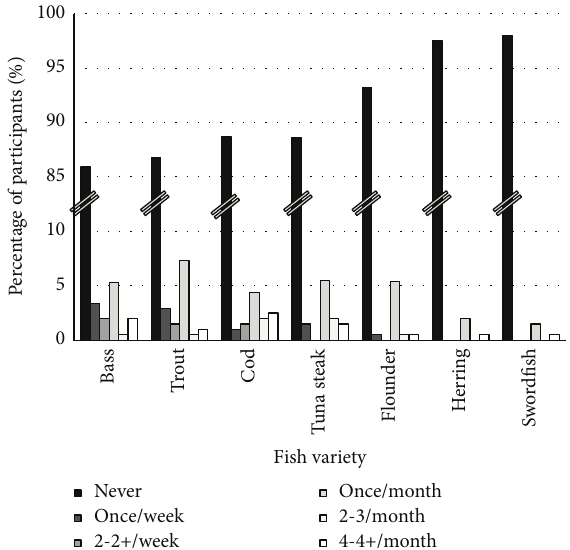
Figure 3: Consumption rate and frequency of the less consumed fish varieties by pregnant women.